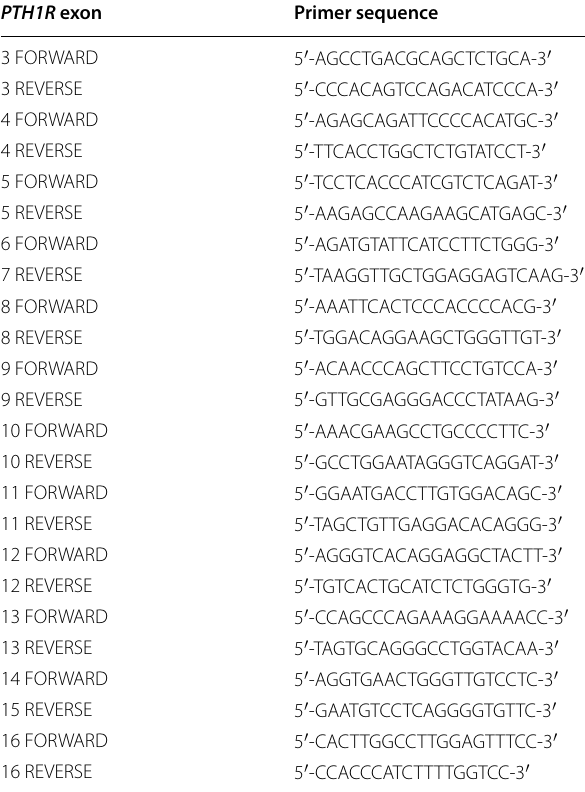
Table 1 Primers employed for sequencing PTH1R coding exons PTH1R